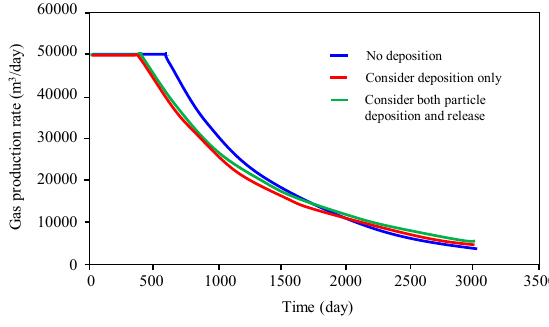
Figure 8. Gas production rate.